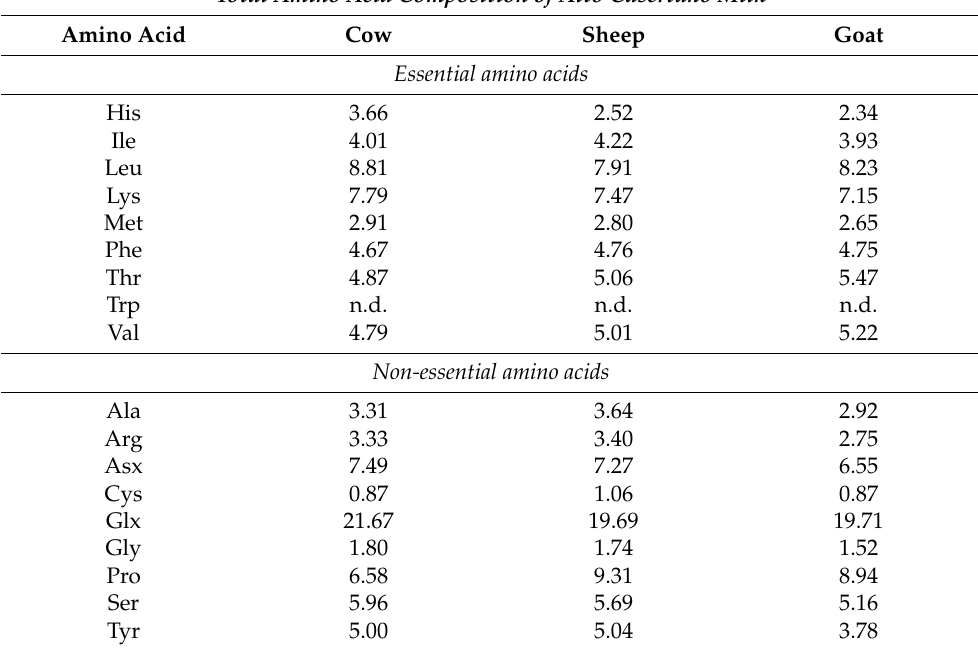
Table 7. Total amino acid composition of ‘Alto Casertano’ raw milk samples. Values are means from ‘Ailano’ and ‘Valle Agricola’ milk and are expressed as g per 100 g of total protein. Total Amino Acid Composition of Alto Casertano Milk Amino Acid Cow Sheep Goat Essential amino acids His